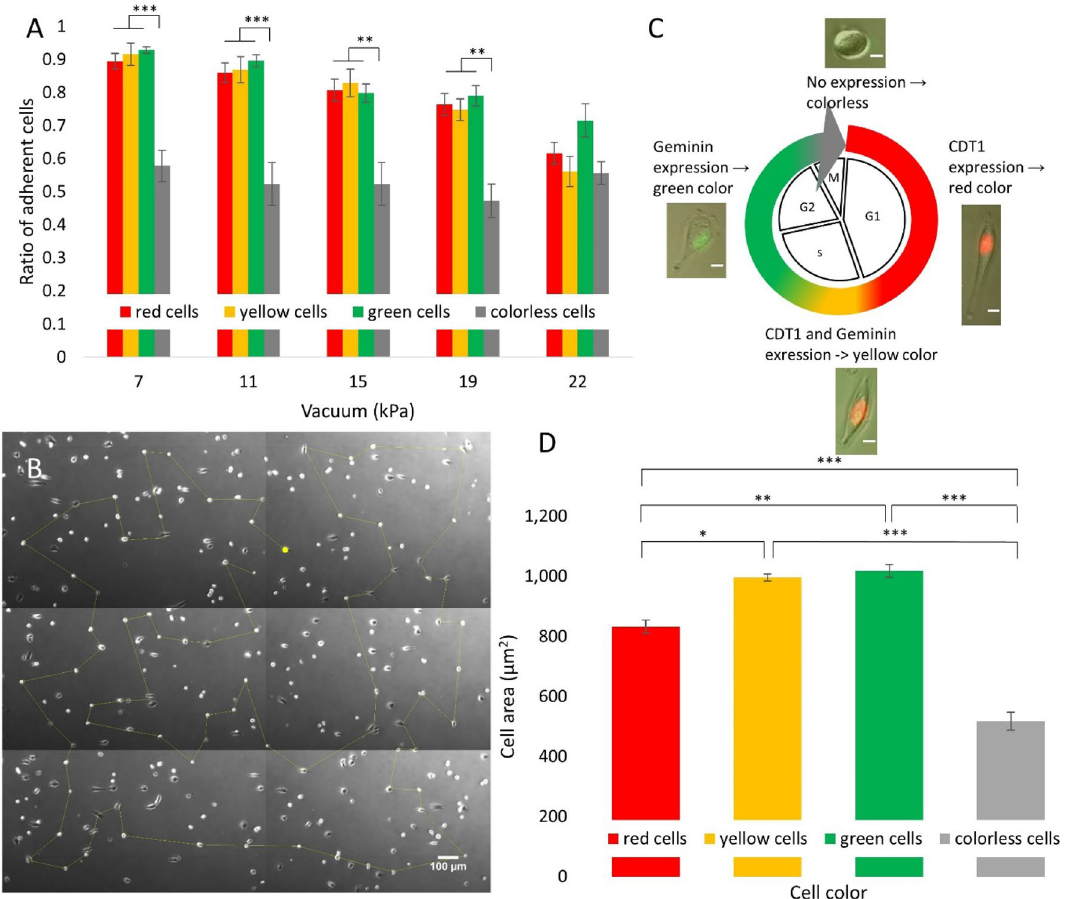
Figure 2. ( A ) Ratio of adherent HeLa Fucci cells on PLL- g -PEG-RGD surface at different vacuum values, as measured by the computer-controlled micropipette. * indicates significant difference between the ratio of different cell phases. ( B ) Phase contrast image of a small area of the Petri dish. The shortest path along all cells selected for measurement was calculated by the CellSorter software and projected onto the image in yellow. ( C ) Expression of the Fucci fluorescent marker set along the cell cycle. The red reporter is attached to the CDT1 protein, expressed early in the cell cycle, while the green reporter is attached to Geminin protein, which is expressed later in the cell cycle. Both reporters are expressed for a short time resulting in yellow color. Neither proteins are expressed during mitosis, making the cells invisible (colorless) in fluorescent images. Scale bar represents 100 µm. ( D ) Correlation between the cell color and the average cell area measured. Bar chart results are from 4 different micropipette experiments, where n = 88 for red cells, n = 90 for green cells, n = 95 for yellow cells and n = 32 for colorless cells. * indicates significant difference between the areas of cells of different